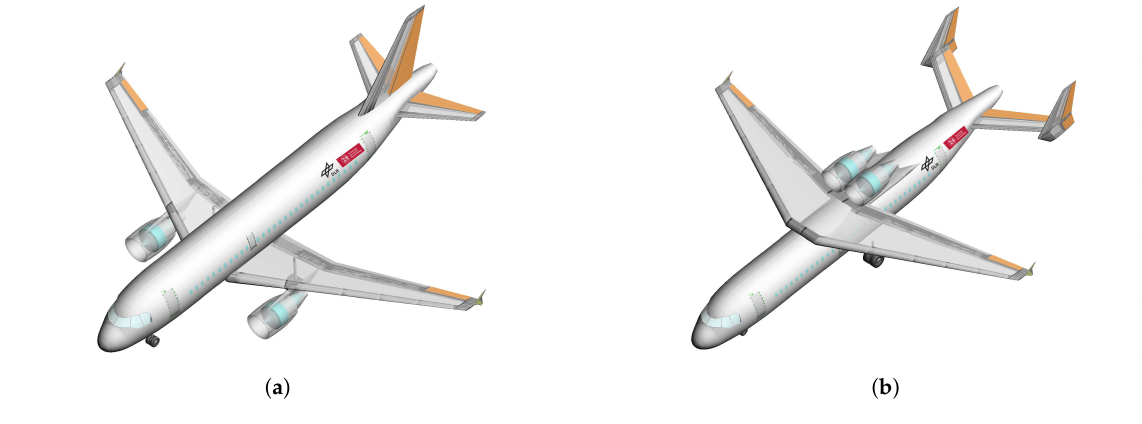
Figure 12. Investigated aircraft configurations—reference ( a ) and low noise ( b ) design. ( a ) Reference aircraft configuration (V-R, “retrofit”); ( b ) Low noise configuration